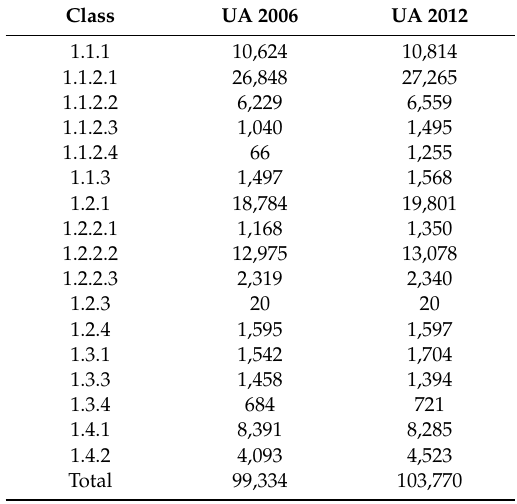
Table A1. The LU / LC in the selected UA nomenclature classes